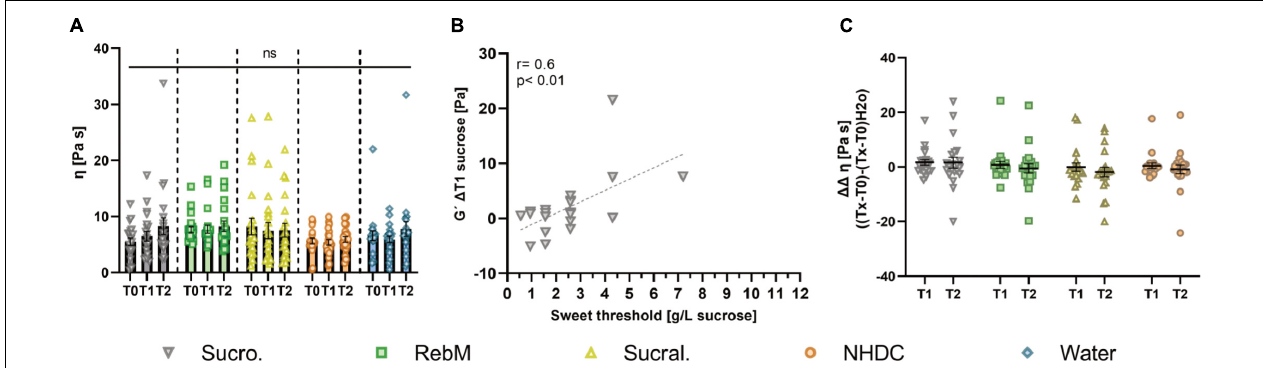
FIGURE 4 | (A) Complex viscosity η (Pa s) of unstimulated (T0) and stimulated saliva in the 1st (T1) and 2nd (T2) min after stimulation with test solutions sucrose (suc.), RebM, sucralose (sucral.), NHDC, and water as control; presented as mean ± SEM; tested for difference with two-way ANOVA and Tukey’s post-hoc test; (ns) no significant results were detected. (B) Normalized complex viscosity η , calculated as (Pa s) [(Tx-T0)-(Tx-T0) H2O ] of saliva samples after stimulation with each test solution; presented as mean ± SEM, n = 21. (C) Pearson product moment correlation for storage modulus G (cid:48) (Pa) (cid:49) T1 after stimulation with sucrose and the sweet taste threshold (g/L sucrose).